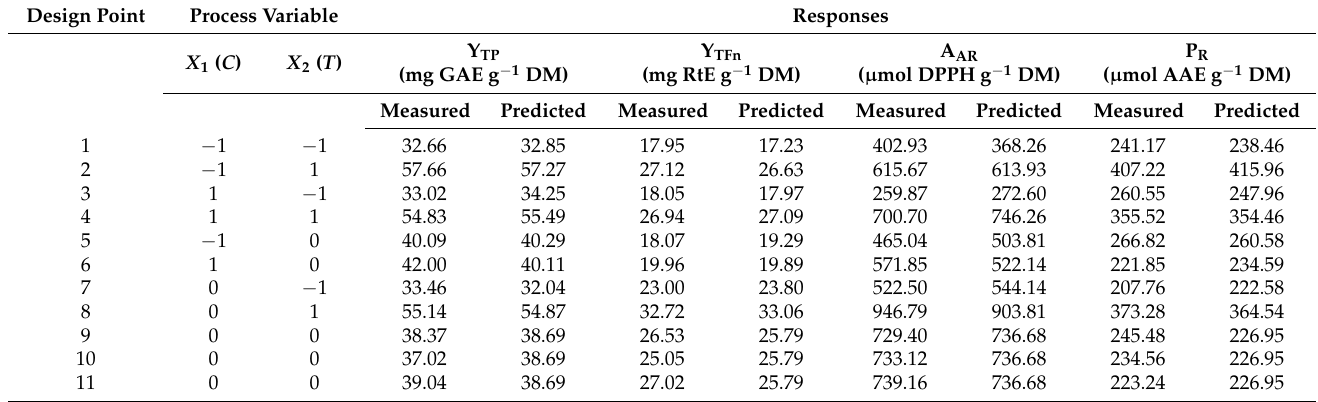
Table 2. The design of experiment used for the response surface methodology, including the design points and the predicted and measured responses.